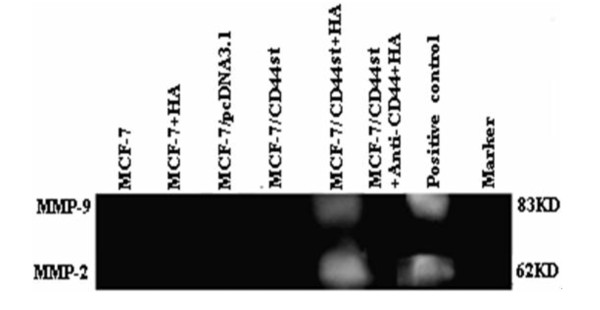
Secretion of HA inducting MMP-2 and MMP-9 protein. Cells treated with HA were incubated in serum free medium with or without HA (100 μg/ml) for 24 h. The secretion of HA inducting MMP-2 and MMP-9 was detected by zymography. Normal human blood was used as a positive control to identify MMP-9 and MMP-2 on gelatin zymograms.